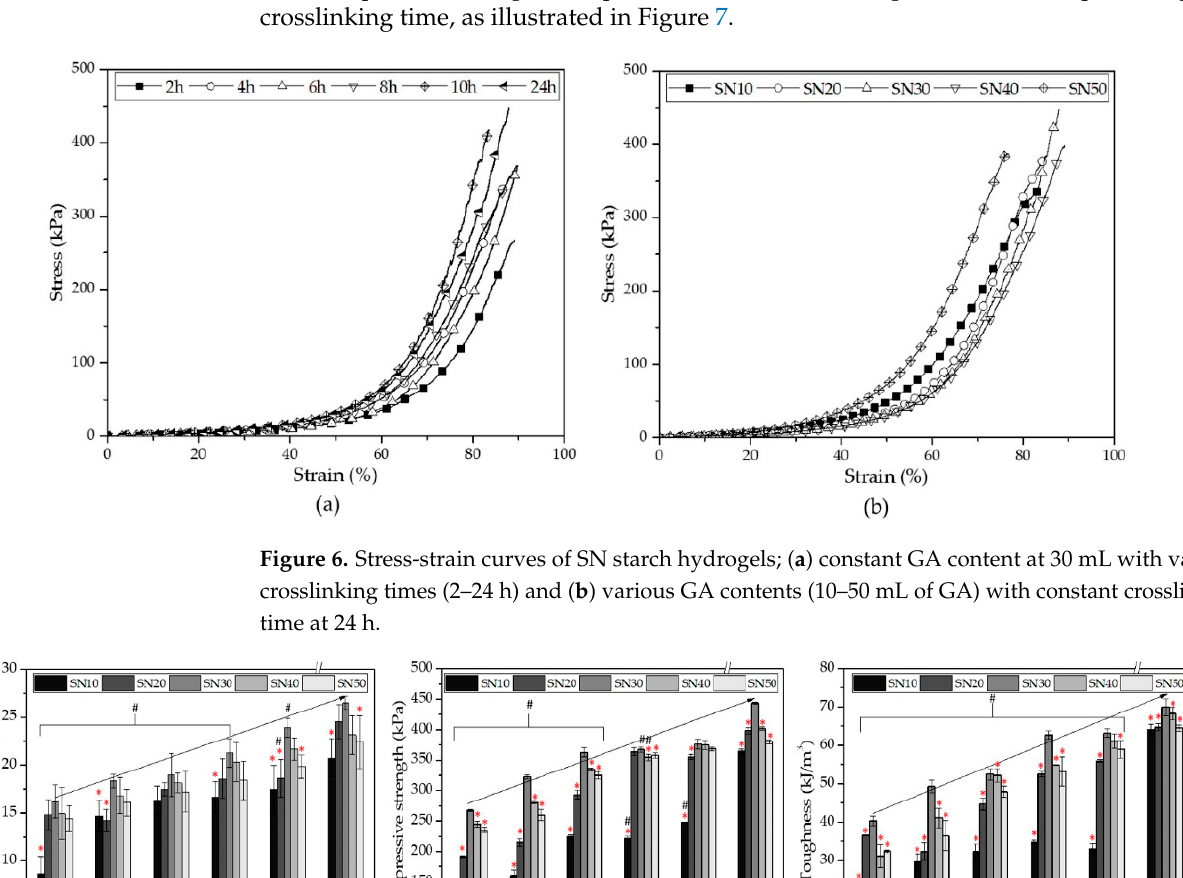
11 of 19 Figure 5. Water uptake of SN starch hydrogels; ( a ) various crosslinking times and GA contents ( n = 3 , * p < 0.05 compared with SN10) and ( b ) SN30 at various crosslinking times from 2–120 h. 3.2.4. Compressive Properties of SN Starch Hydrogels